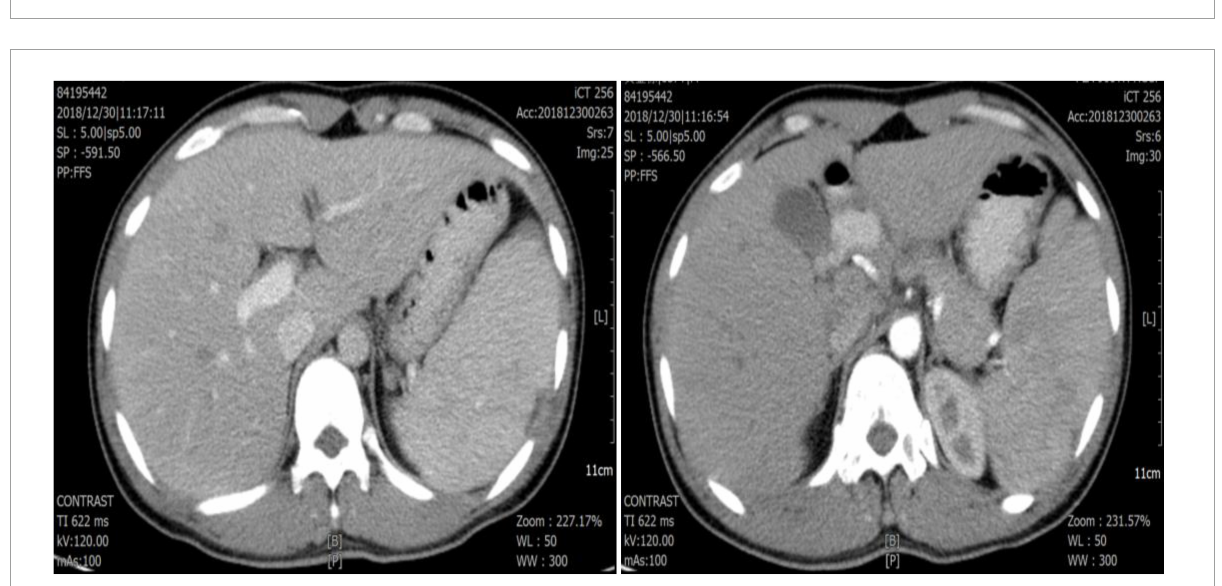
FIGURE2 Abdominal computed tomography showed splenic infarction.